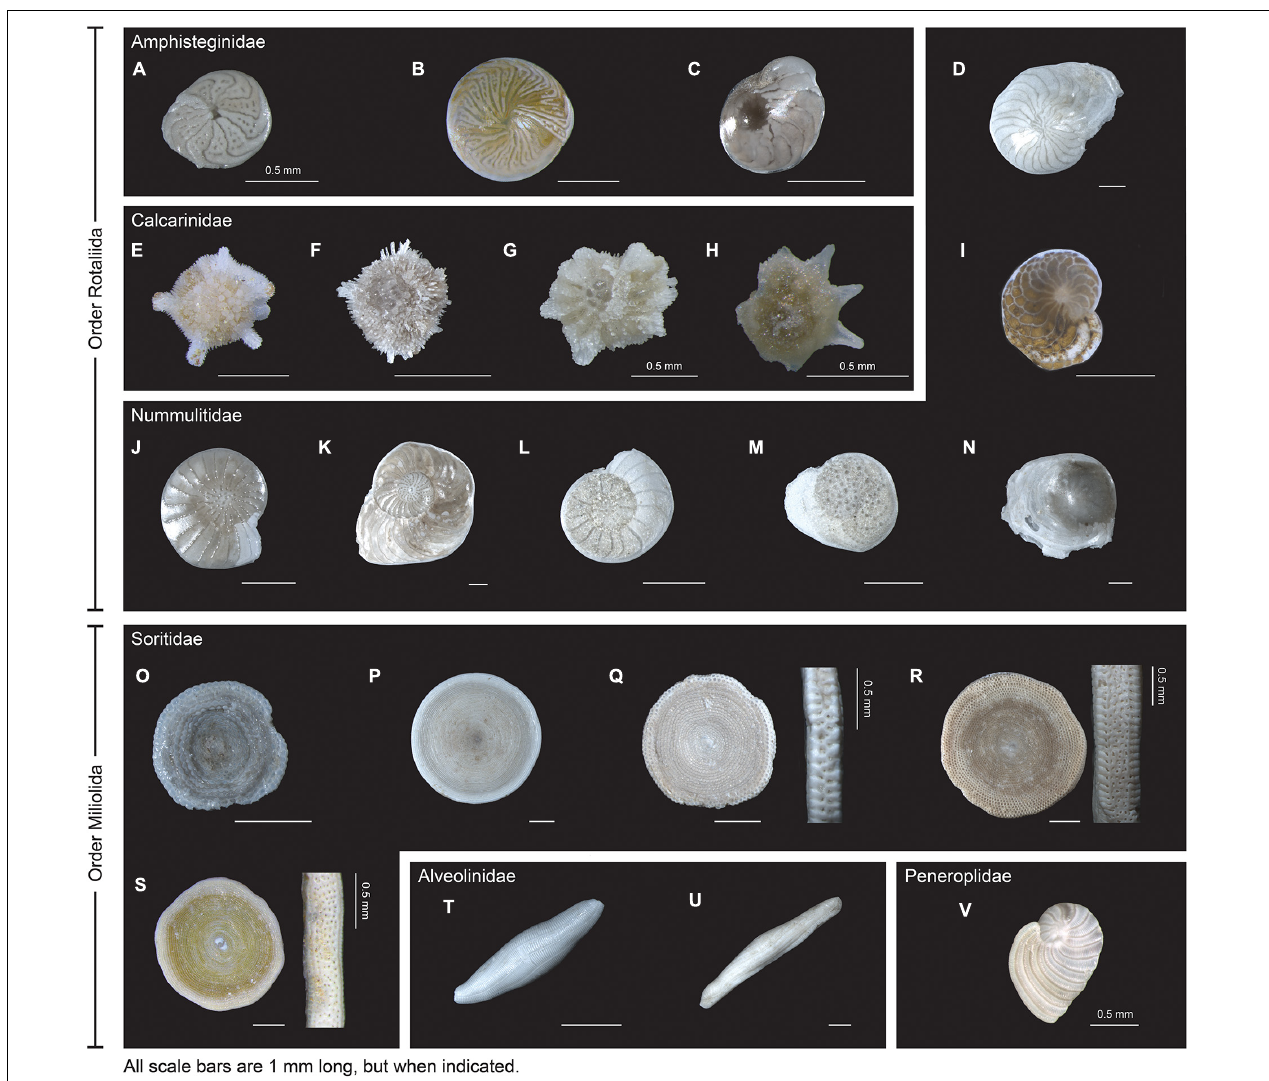
FIGURE 1 | External view of the 22 species barcoded. Order Rotaliida: (A) Amphistegina papillosa. (B) A. radiata. (C) A. lessonii. (D) Nummulites venosus. (E) Calcarina hispida. (F) Calcarina sp1. (G) Neorotalia gaimardi. (H) N. calcar. (I) Heterostegina depressa. (J) Operculina ammonoides. (K) O. LKI27 type. (L) Operculina sp1. (M) O. complanata. (N) Operculinella cumingii. Order Miliolida: (O) Sorites sp. (P) Parasorites sp. (Q) Amphisorus SpS. (R) A. SpL. (S) Marginopora vertebralis. (T) Borelis schlumbergeri. (U) Alveolinella quoyi and (V) Peneroplis planatus. The scale bar is 1 mm unless indicated